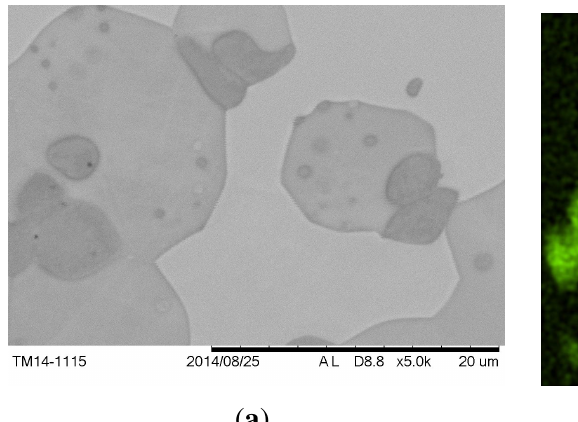
Figure 6. SEM-image of the same sample as in Figure 5(a). ( a ) Back scattered electrons; ( b ) X-ray signals of Cr-K α